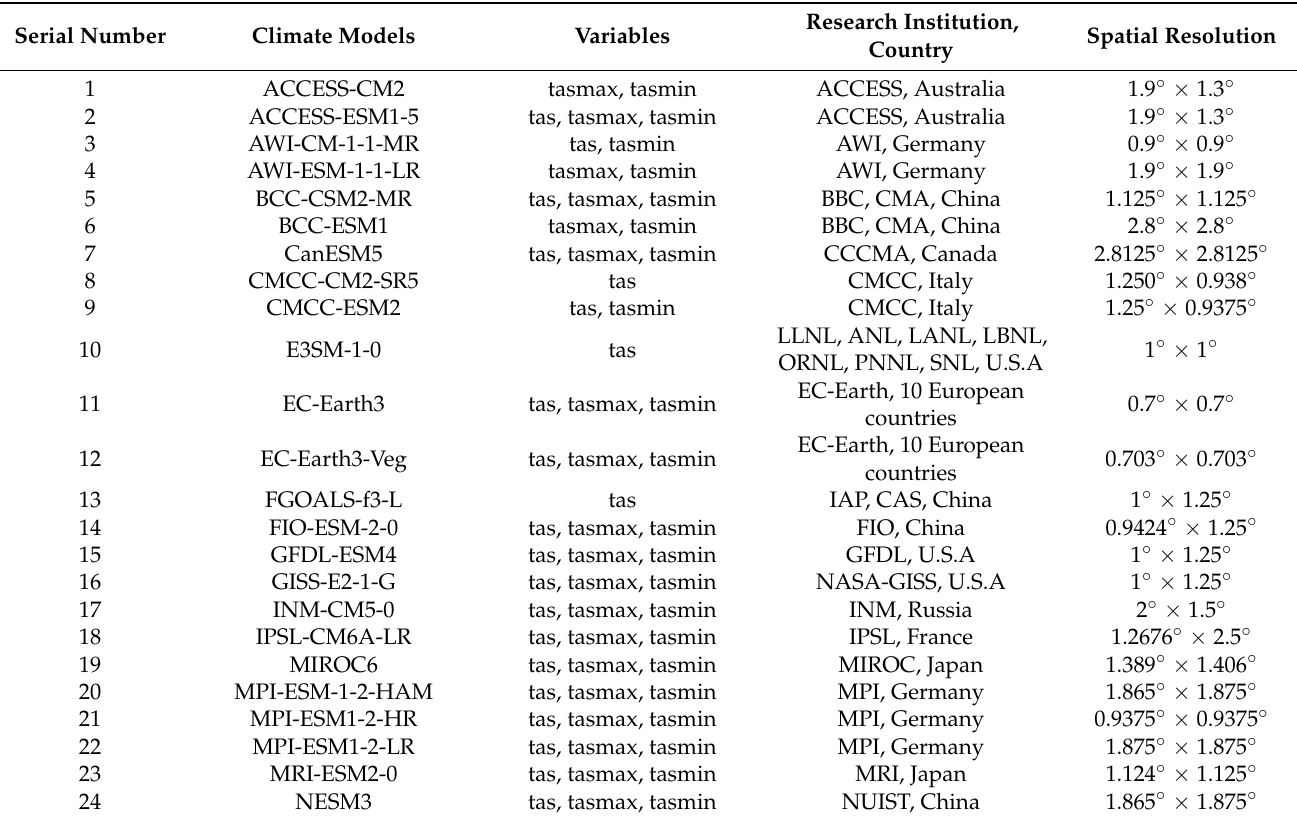
Table 1. Introduction to climate models with temperature